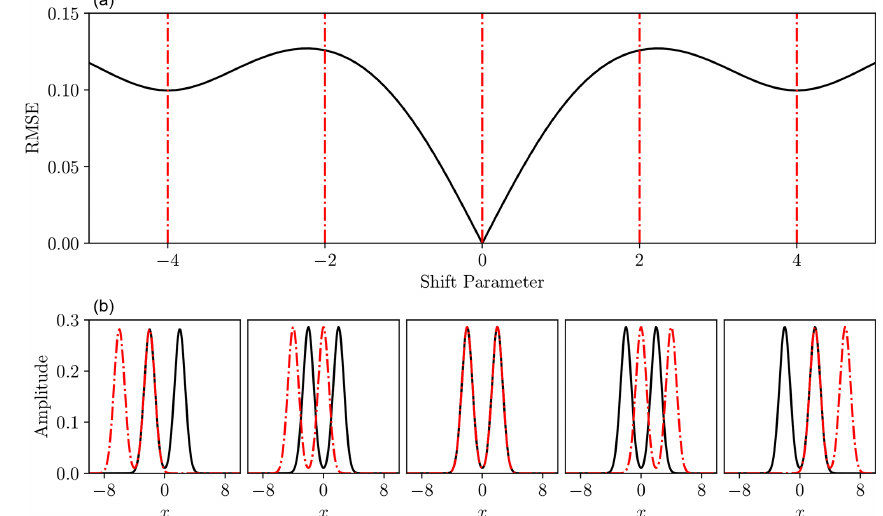
Figure 3. Root mean square error (a) between double Gaussians at a variety of time shifts ( b , solid black and dash-dot red). Panel (b) cor- responds to shift parameters indicated in panel a) with dash-dot red lines. In this example the situations shown in the far-left and far-right lower panels, with shift values of − 4 and 4 respectively, both represent local minima in the RMSE function above, because the black curve has just a single peak aligned with the red dash-dot curve in each case, whereas the global minimum at shift value 0 has both peaks aligned.